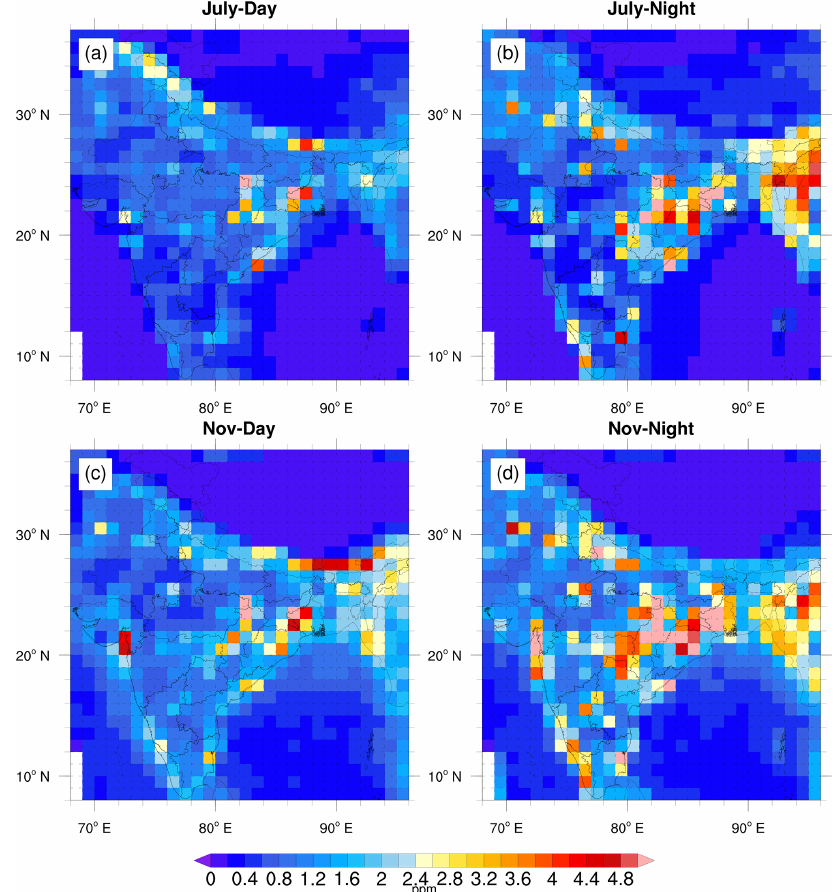
Figure 4. Monthly averaged values of representation error estimated for surface CO 2 concentration (second model level; mean height is ∼ 200m from sea level) over the region 8 to 37 ◦ N and 68 to 96 ◦ E during 2017. (a) July daytime (11:30 to 16:30LT). (b) July nighttime (23:30 to 04:30LT). (c) November daytime. (d) November